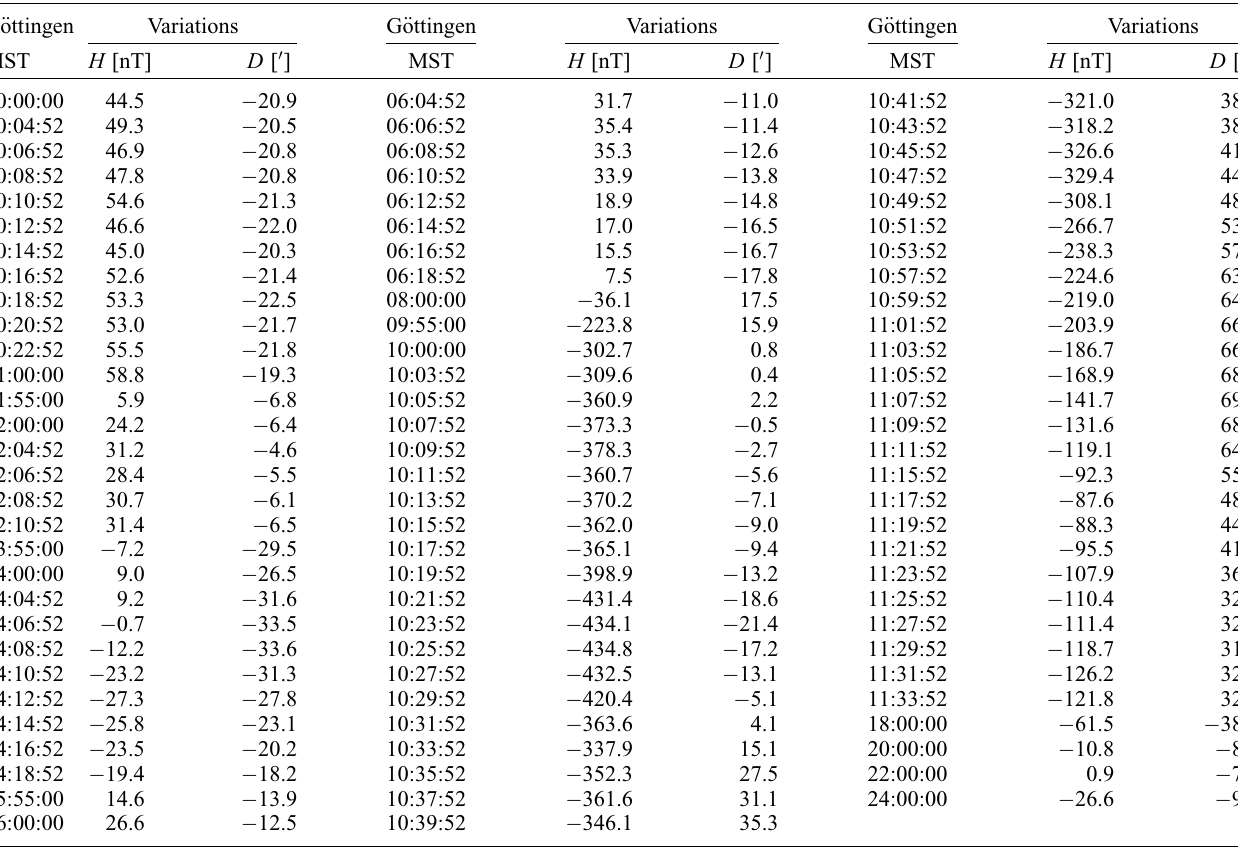
Table A1. The digital data of the Clementinum storm, variations of the horizontal intensity and variations of the declination, recorded on 17 November 1848 by Kreil and Jelinek (1850). The fi rst column in the table is the G € o ttingen Mean Solar Time (MST), which is ~40 min ahead of the Greenwich MST and ~18 min behind of the Clementinum